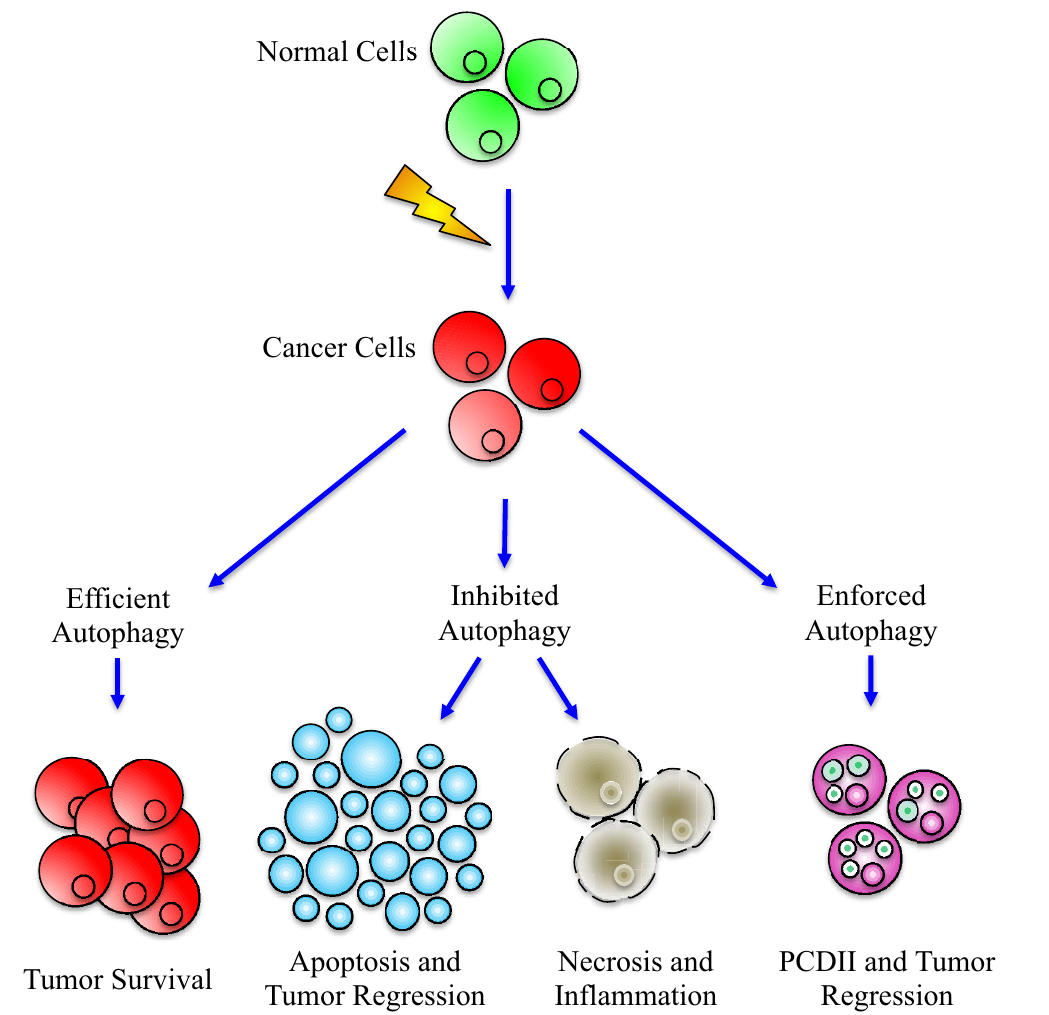
Figure 3. Effects of efficient or deregulated Autophagy in cancer development . Alteration of autophagy may have different effects on cancer cells: when efficient, the